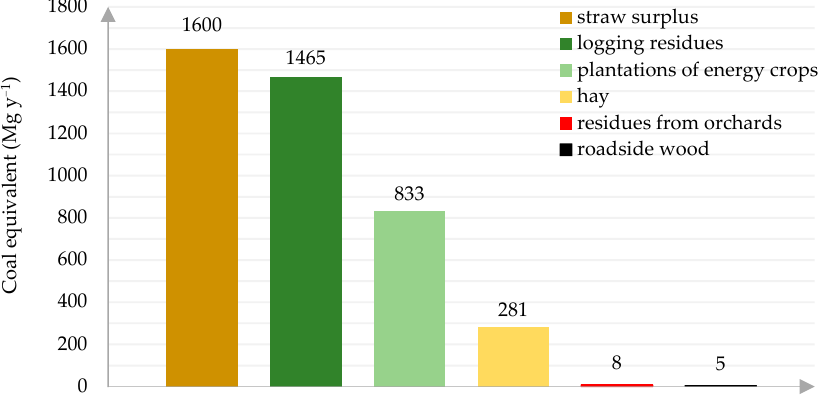
Figure 3. The potential of energy accumulated in solid biomass resources expressed as the coal equivalent (Mg y − 1 ).